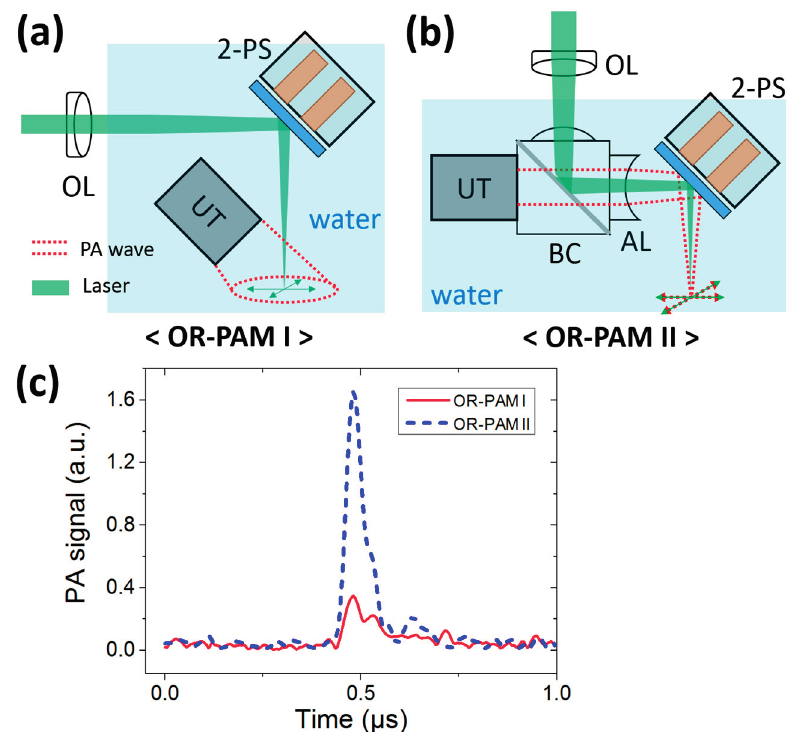
Figure 5. Comparison of signal-to-noise ratios in two forms of OR-PAM. ( a ) Schematic of the OR-PAM I system. An unfocused ultrasound transducer is used and the laser beam is only scanned by the 2A-PDMS-WP-scanner; ( b ) Schematic of the OR-PAM II